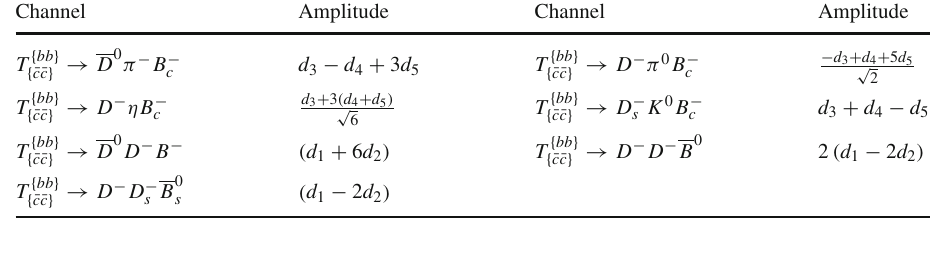
{ bb } Table 7 Tetraquark T Channel Amplitude Channel {¯ c ¯ c } decays into three mesons induced by the charmless b → s transition